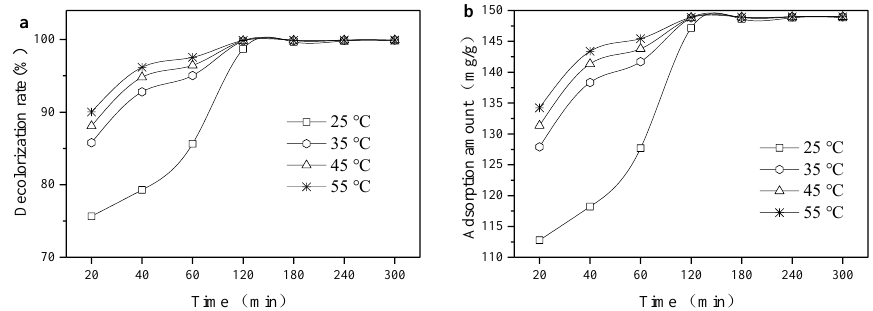
Figure 8. E ff ect of temperature condition on the decolorization rate ( a ) and adsorption amount ( b ). The adsorption test was conducted with a 300 mg / L MG solution and 2 g / L of modified sepiolite under an oscillation rate of 170 r / min.